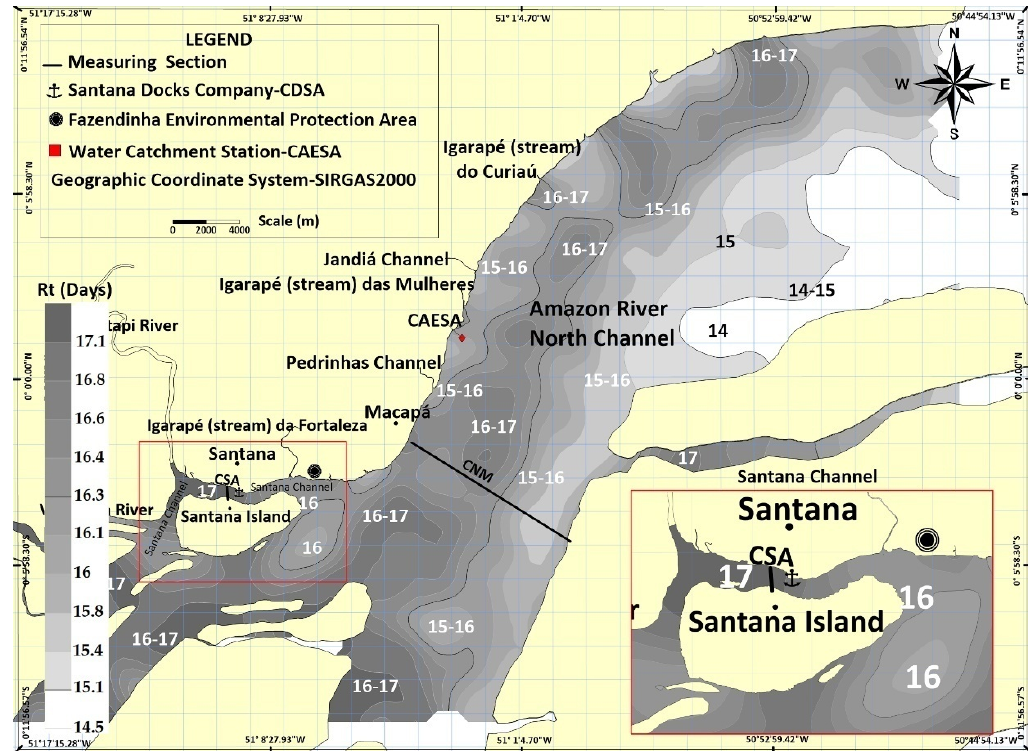
Figure 10. CNM and CSA’s water residence time (Rt) in May at time unit expressed in days. Geographic Coordinate System: Sirgas2000.